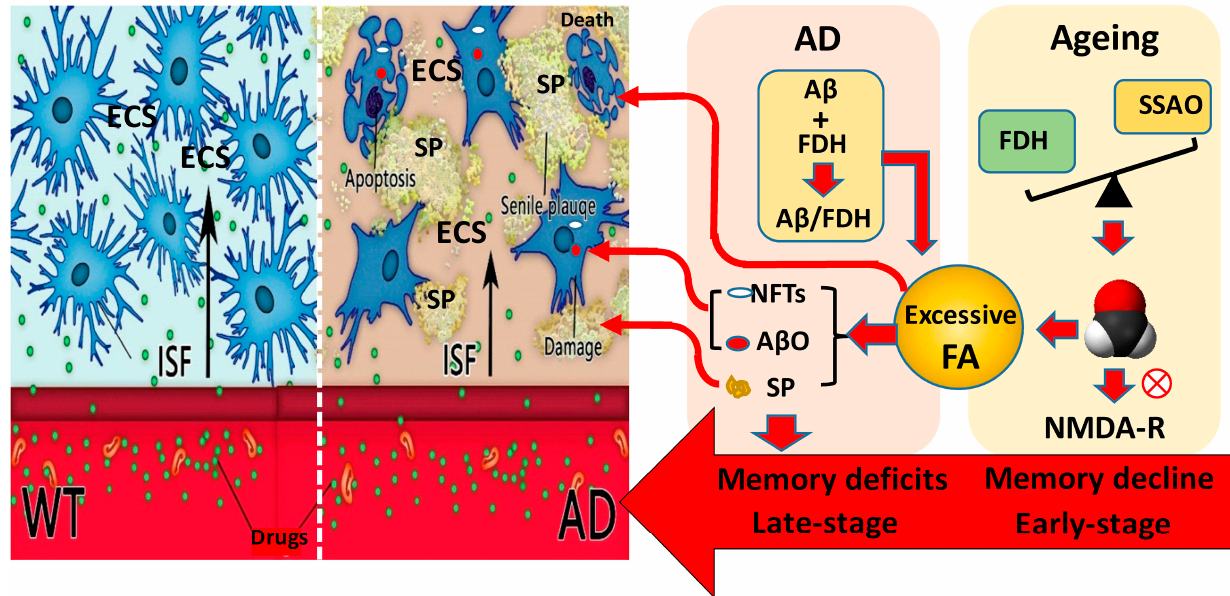
Figure 3. Novel pathogenesis, drug target and delivery in AD. Briefly, aging induces endogenous formaldehyde accumulation by disrupting FDH and SSAO expression [170,171]. Excessive formal- dehyde can directly induce neuron death and cognitive decline by inhibiting NMDA receptor [172]. Especially, both age-associated formaldehyde and A β -inactivated FDH-derived formaldehyde elicit the formation of intracellular A β O and NFTs and extracellular SP [18,173,174]. Formaldehyde-in- duced A β deposition in ECS blocks ISF drainage and drug delivery [18].